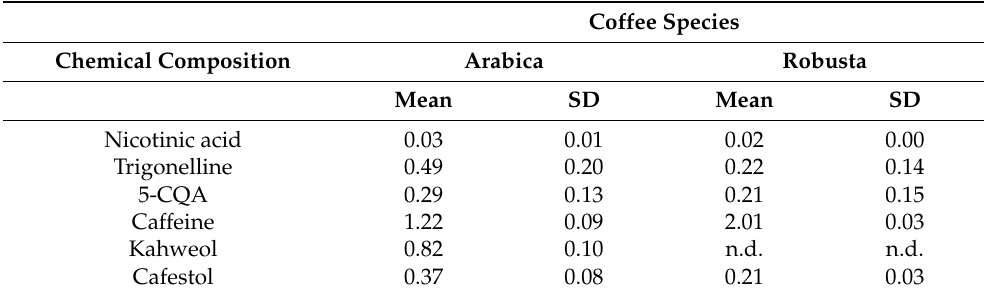
Table A1. Differences in chemical composition (g per 100 g of sample in dry base) of coffee species. Adapted from De Souza, R.M.N.; Benassi, M.T.